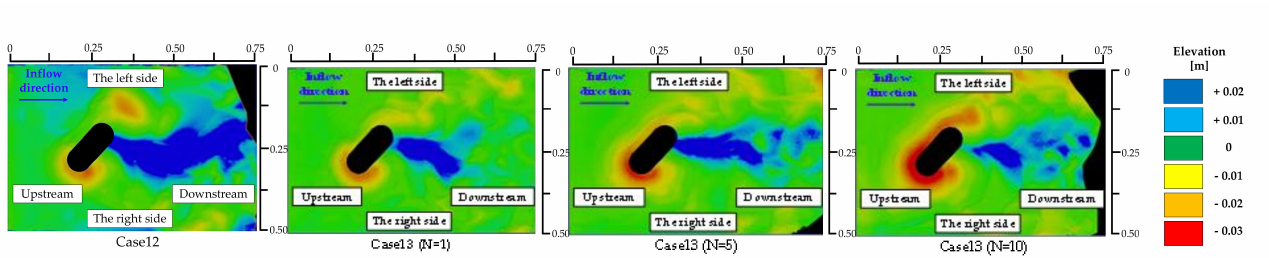
Figure 4. Local scour depth after the experiment for Cases 10 and 11. ( θ = 30 ◦ , H 1 = 0.075 m, T = 600 s).